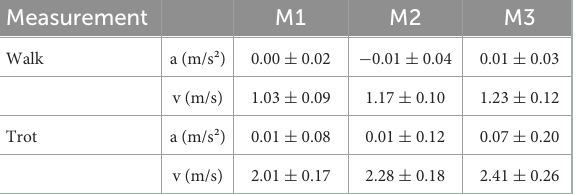
TABLE 2 Speed (v) and acceleration (a) (mean ± SD) (calculated for the left hind limb) when walking and trotting for Labrador Retrievers ( n = 32) at the three measurement points (M1 = 4 months, M2 = 8 months, and M3 = 12 months of